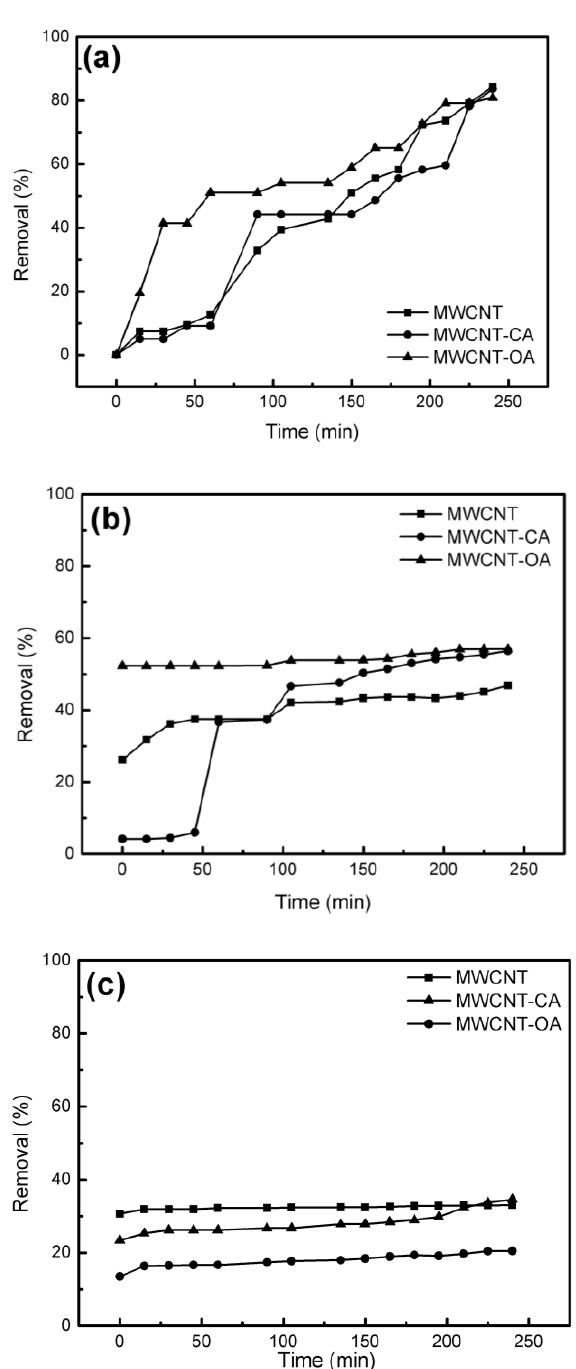
Figure 8. Removal percentage of ( a ) urea ( b ) creatinine and ( c ) uric acid with MWCNT, MWCNT-CA, MWCNT-OA.